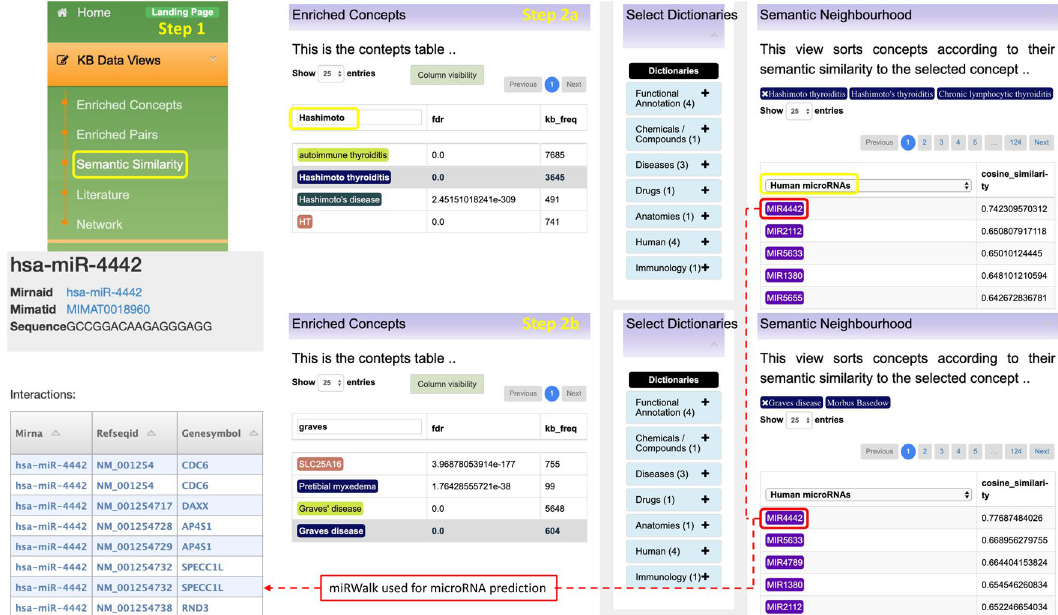
Figure 2. The step-by-step illustration of how DES-Tcell can be used to identify microRNA’s potentially association to Grave’s disease (step 2a) and Hashimoto’s thyroiditis (step 2b) and provide the potential target of the identified